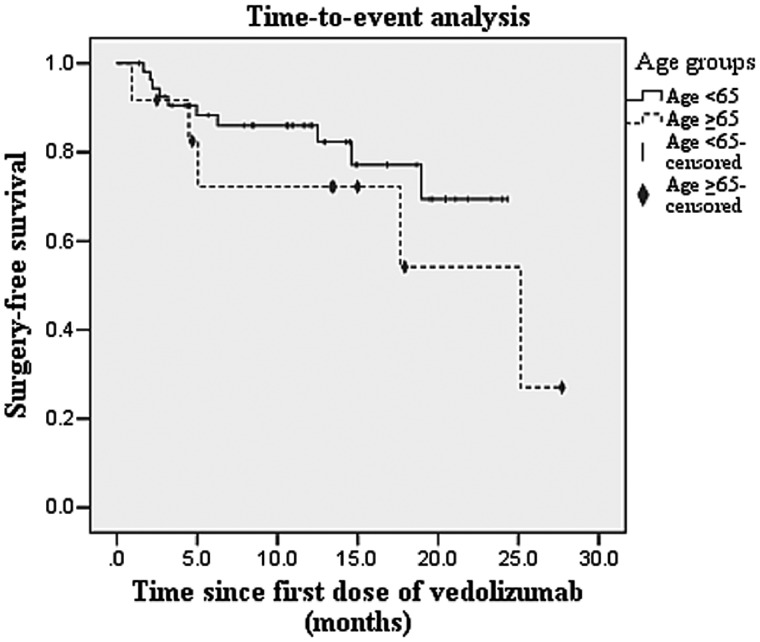
Kaplan–Meier curves comparing surgery-free survival between the elderly (age ≥65 years) and younger (age <65 years) groups